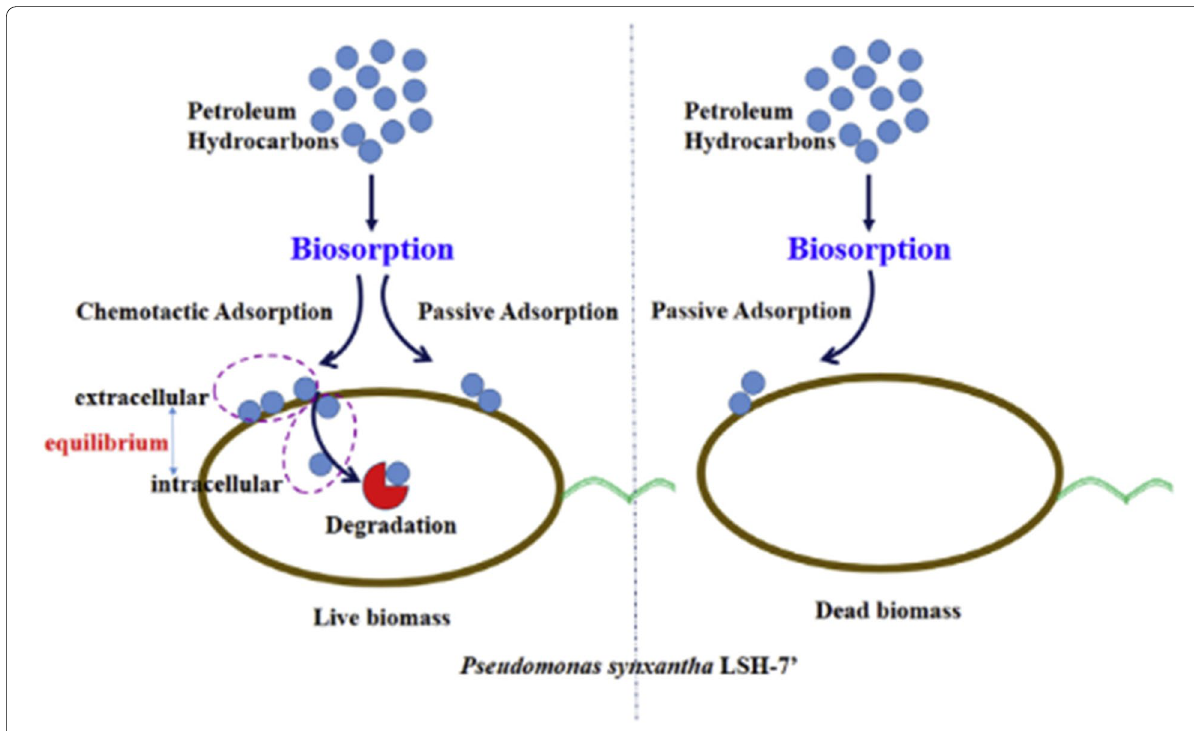
Fig. 4 Sketch diagram of bacterial chemotactic biosorption (Meng et al.